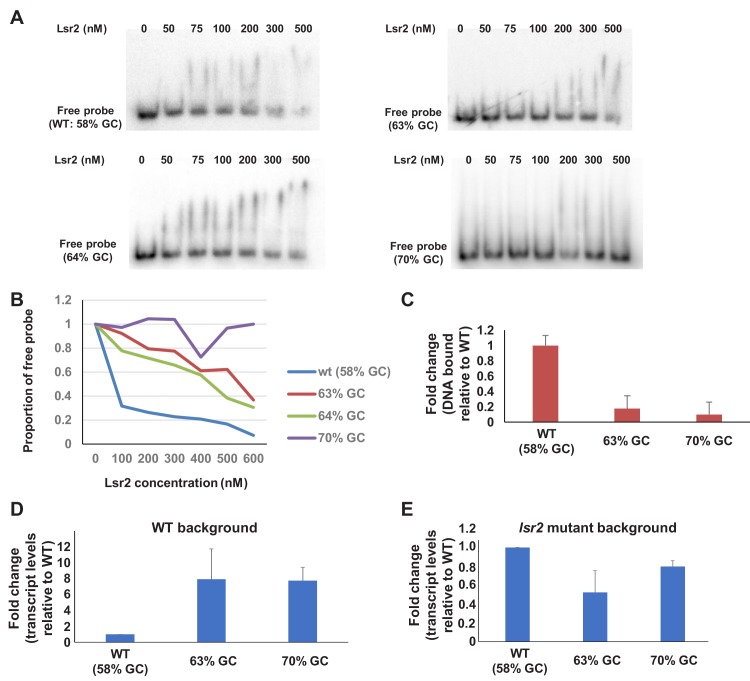
Effect of increasing GC content on Lsr2 binding and activity.(A) EMSAs performed using probes (1 nM) having increasing GC-content, together with increasing concentrations of Lsr2. Probes corresponded to a 124 bp region between the Lsr2 targeted binding site between sven_5106 and sven_5107, where AT nucleotides (outside of the promoters for the flanking genes) were mutated to increase the GC content. (B) Quantification of free probe remaining following incubation with increasing concentrations of Lsr2, from EMSAs shown in (A). The different probes are represented by the colors indicated on the right. (C) Quantitative PCR of a region corresponding to the beginning of sven_5105, after ChIP (using anti-FLAG-antibodies specific for Lsr2−3× FLAG) to follow Lsr2 binding to a wild type or mutated (increasing GC content) sequence between sven_5106–5107, relative to binding to the wild type sequence. (D) RT-qPCR assessing transcript levels of sven_5106 in a wild type Lsr2-expressing strain (D) bearing wild type or mutant Lsr2 binding sequences between sven_5106–5107. (E) Same as (D), only conducted in an lsr2 mutant background, to ensure that the mutations in the Lsr2 binding site only affected Lsr2 binding, and did not generally enhance promoter activity for sven_5106. All EMSA experiments were performed in duplicate or triplicate, with representative results shown. ChIP-qPCR and RT-qPCR experiments were performed using biological duplicates and technical triplicates.